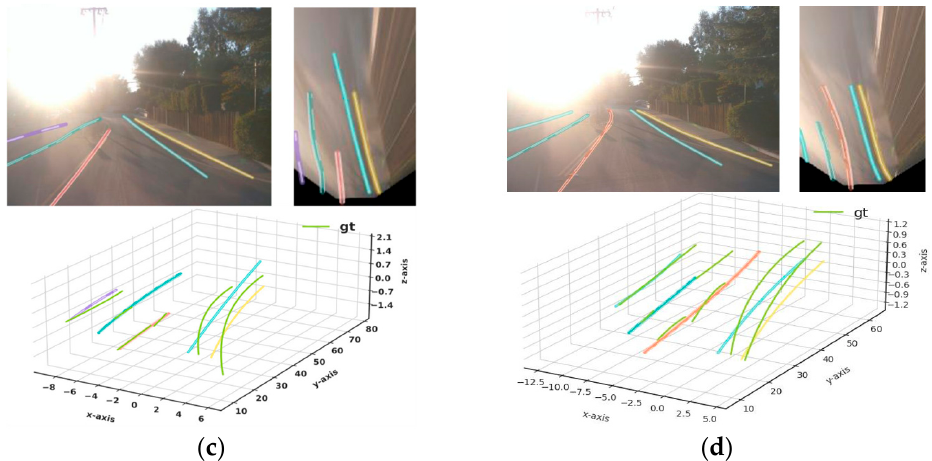
Figure 8. Qualitative comparison between: ( a ) 3D-LaneNet [34], ( b ) Gen-LaneNet [35], ( c ) PersFormer [13], and ( d ) proposed method on weather case.